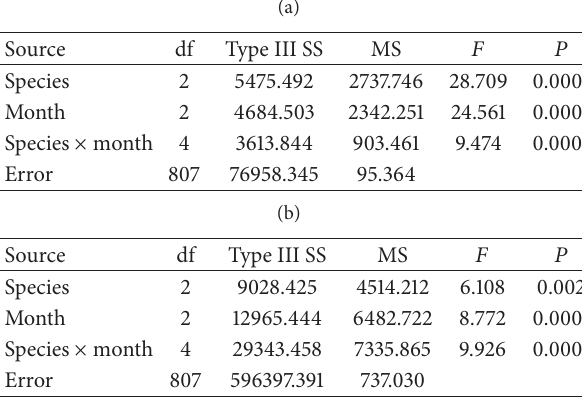
Table 2: ANOVA describing the direct and interactive effects of species (“species”) and sampling period (“month”) on (a) perch height and (b) perch distance from open water, for males of Celithemis ornata , C. elisa , and C. fasciata at Ashmore Heritage Trust Preserve, Greenville County, USA.